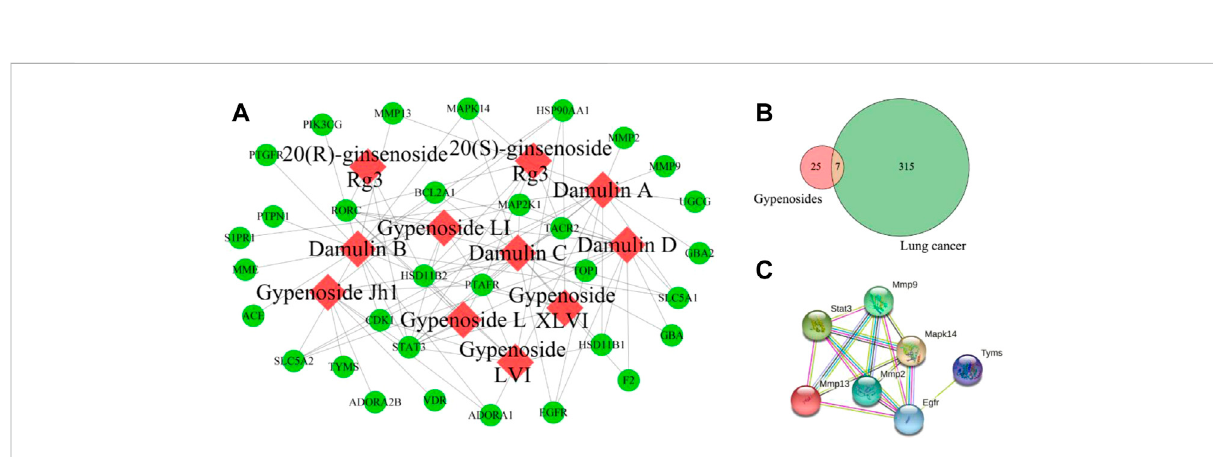
FIGURE 9 The compounds-target network of GYP on lung cancer, the red nodes and green nodes represent 11 saponin components and genes (A) ; Wayne diagram of intersection gene between GYP and lung cancer (B) ; PPI network for GYP against lung cancer (C)